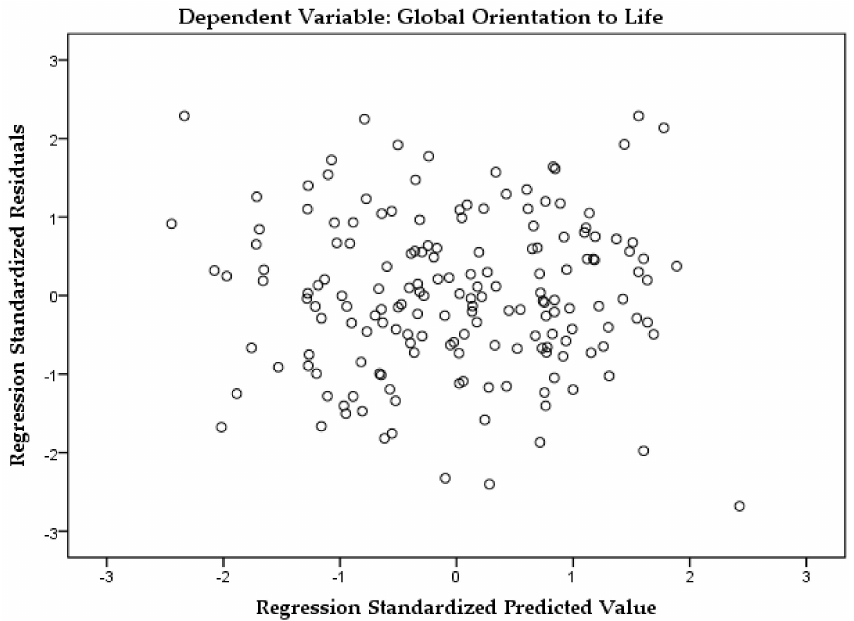
Figure 1. The scatterplot of the standardized residuals against standardized predicted